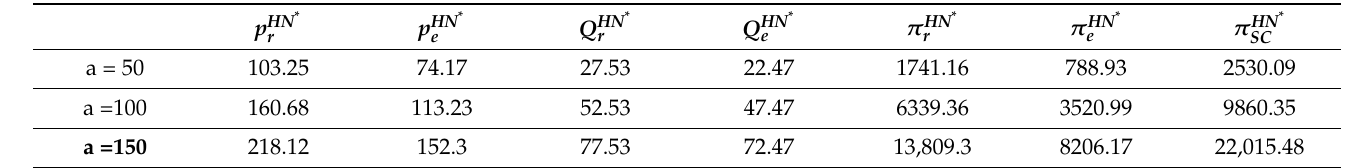
Table 7. Optimal decisions of channel members under the HN game—Case 3.